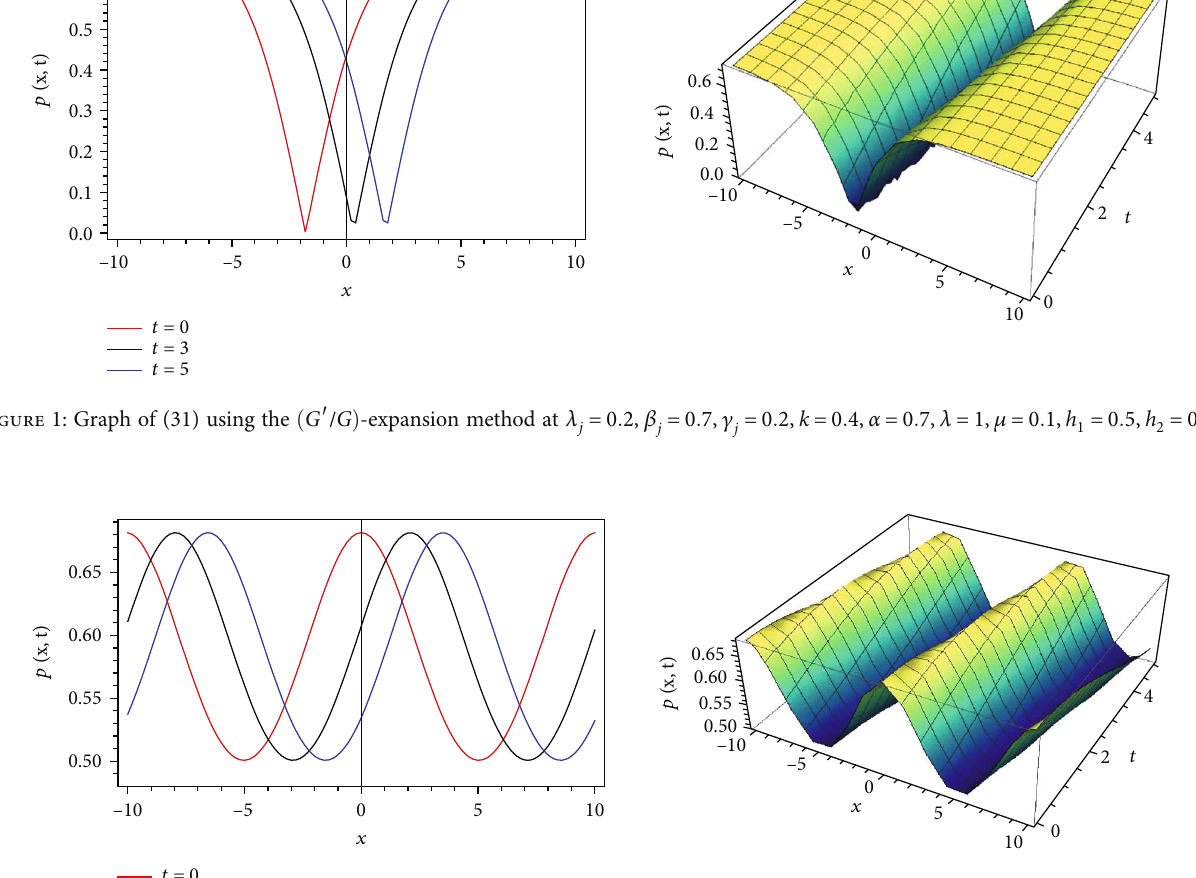
Figure 2: Graph of (32) using the ð G ′ / G Þ -expansion method at λ